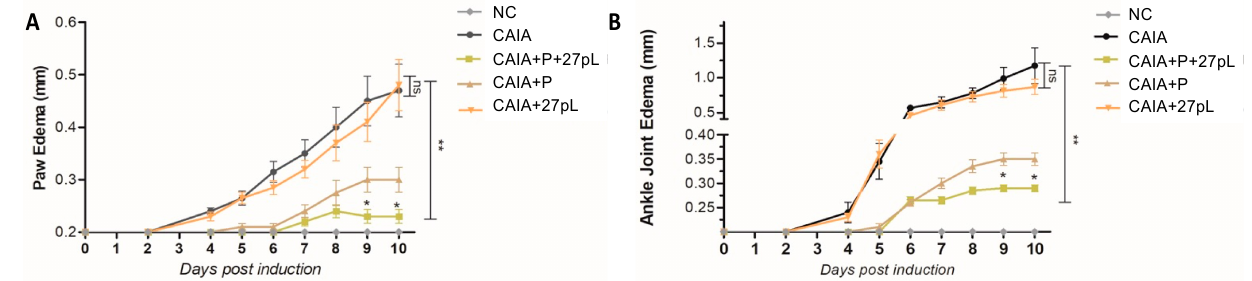
Figure 3. Prenidsone reduced ankle joint and paw edema and this effect was enhanced by 27pL. ( A ) CAIA animals developed paw edema, but treatment with Prenidsone (P) significanly reduced this phenotype. Dual therapy with P + 27pL further improved paw edema on days 9 and 10 post-induction. ( B ) Increase in ankle edema is also typically observed in CAIA animals, yet P significantly reduced this phenotype, with dual P + 27pL further improving ankle edema on days 9 and 10 post-induction. Results represent mean ± SEM. This figure is the combination of two independent experiments. A one-way analysis of variance (ANOVA) followed by Tukey’s multiple comparison t -test was used to calculate the statistical difference. The Mann–Whitney non-parametric test was used to calculate the statistical difference between P and P + 27pL (* p ≤ 0.05; ** p ≤ 0.01), with ns, not signifi- cant.